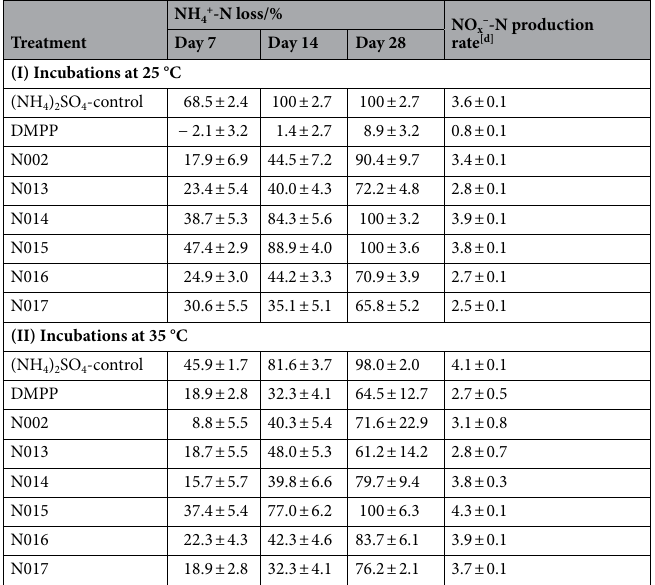
Table 2. Ammonium loss (%) during a 28-day incubation and NO x – -N production rate in Horsham soil (pH 8.8). All samples were treated with the fertiliser (NH 4 ) 2 SO 4 at a rate of 100 mg N kg -1 .[ a , b , c ]. [ a ] Application rates are 10 mol% of applied fertiliser N. [ b ] Ammonium loss was calculated from NH 4 + -N concentrations detected in samples at each timepoint. [ c ] Mean values (n = 3); errors are standard errors of the mean. [ d ] After 28 days; in mg NO x – -N/kg